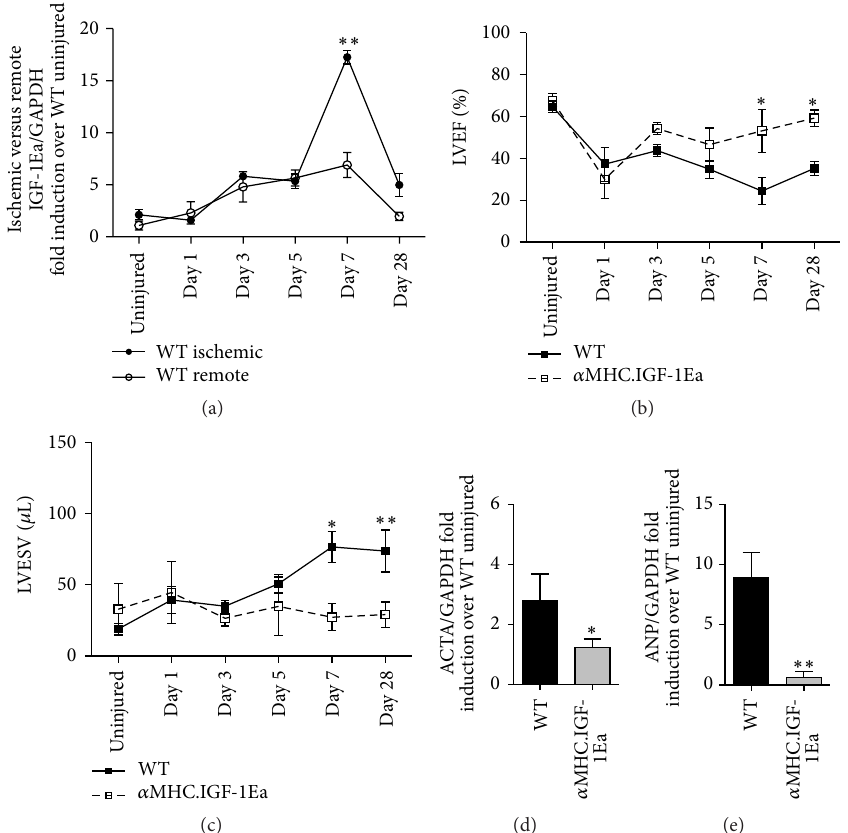
Figure 1: 𝛼 MHC.IGF-1Ea improves cardiac function and reduces dilation as early as 7 days after myocardial infarction. (a) Levels of IGF-1Ea in the ischemic and in the remote area of WT hearts at 1, 3, 5, 7, and 28 days following MI. (b) Left ventricular ejection fraction (LVEF) and (c) left ventricular end systolic volume (LVESV) after MI. Solid lines represent WT mice. Dashed lines represent 𝛼 MHC.IGF-1Ea mice. Levels of (d) actin-alpha 1 skeletal muscle (ACTA 1) and (e) atrial natriuretic peptide (ANP) mRNA expression 28 days after MI. Results are expressed as mean fold induction ± SEM over the values of uninjured hearts. 𝑛 = 4 –6 per group. Two-tailed Student’s t -test was performed to compare WT versus 𝛼 MHC.IGF-1Ea at selected time points after MI. ∗ 𝑃 < 0.05 , ∗∗ 𝑃 < 0.005